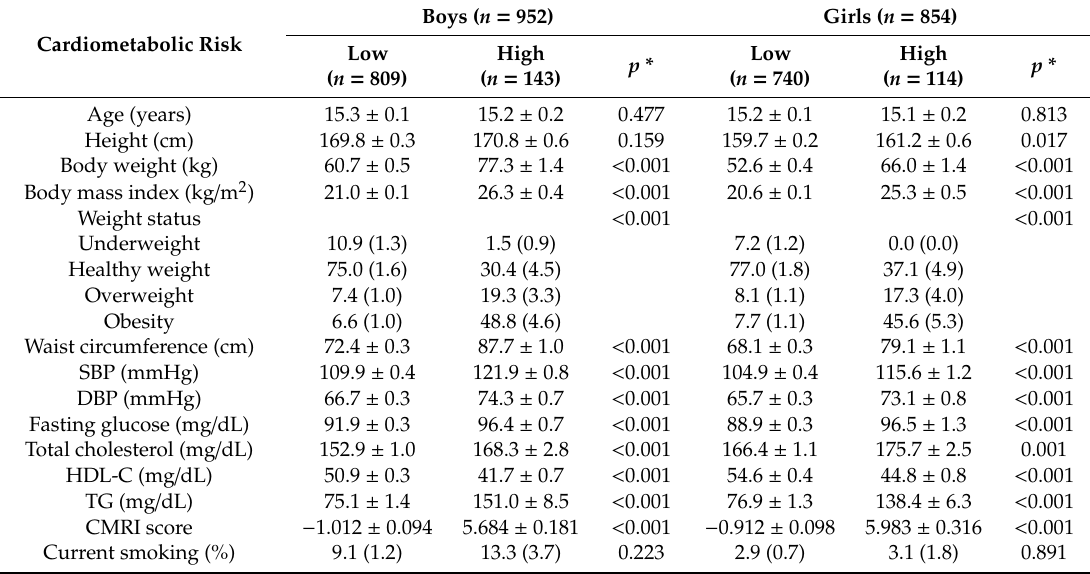
Table 1. Clinical characteristics, biochemical profile, handgrip strength, and sedentary time of adolescents according to cardiometabolic